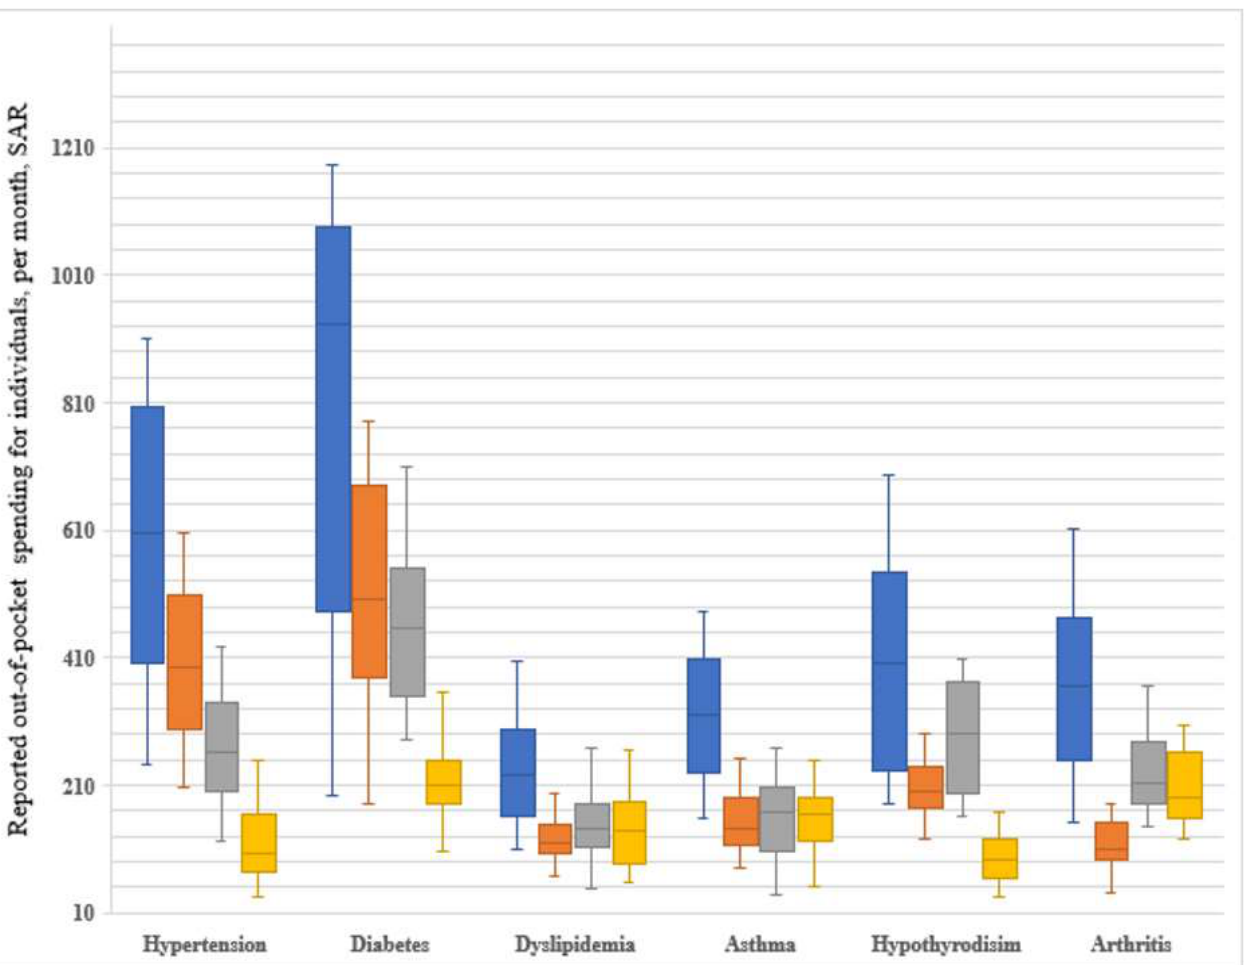
Figure 2. Box-and-whisker plots of OOP spending per individual with NCDs per